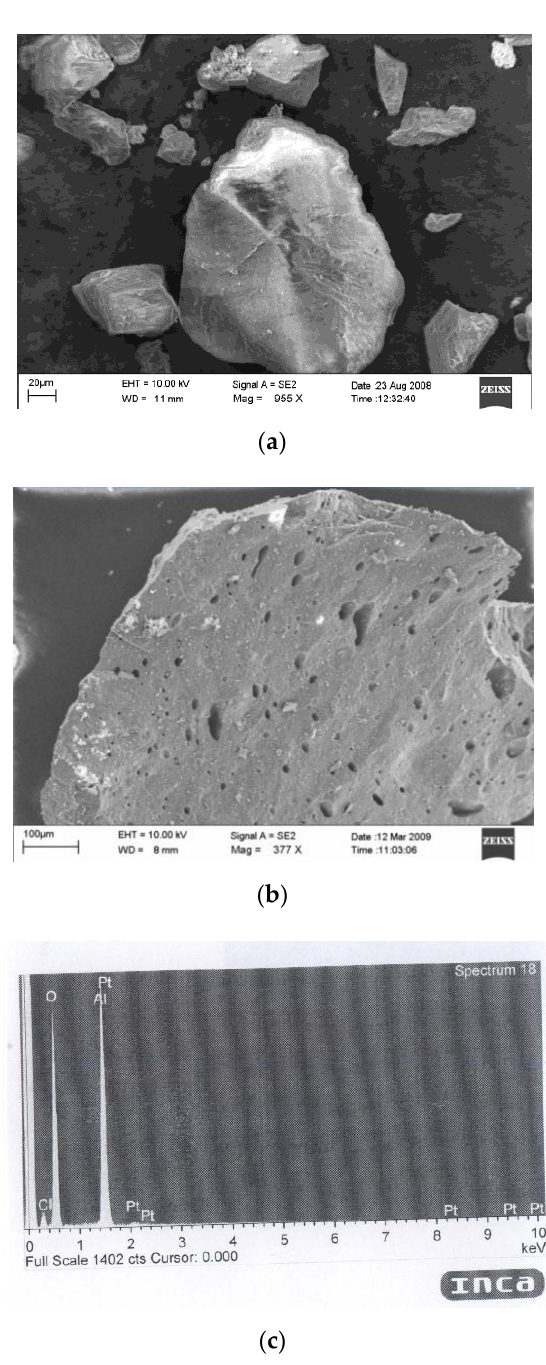
Figure 1. Two different chlorinated zeolites with extruded morphological exposer with an EDS spectrum: ( a ) top view; ( b ) segmented view of catalyst pellet and ( c ) EDS spectrum of top view. Table 3. The composition of elemental metals presents over the section of catalyst surface for segmented Extruder and Pt-Cl/ H -β-zeolite by energy-dispersive spectroscopy (EDS) spectra collected following the SEM technique.